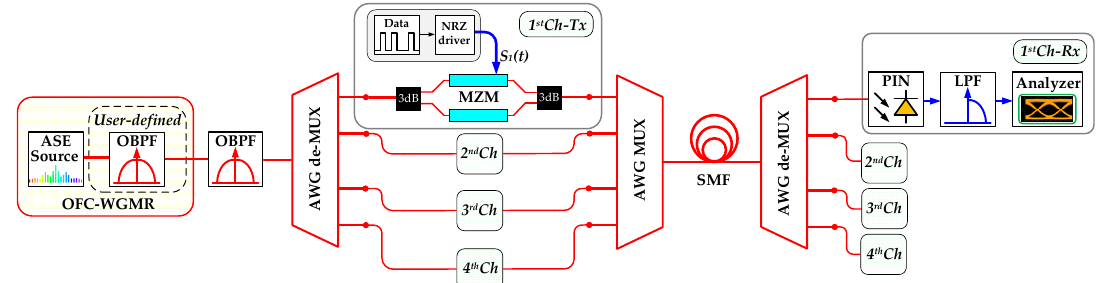
Figure 9. Simulation model of the 4-channel 200 GHz spaced IM / DD WDM-PON system used for the designed silica microsphere-based OFC comb spectrum implementation and performance